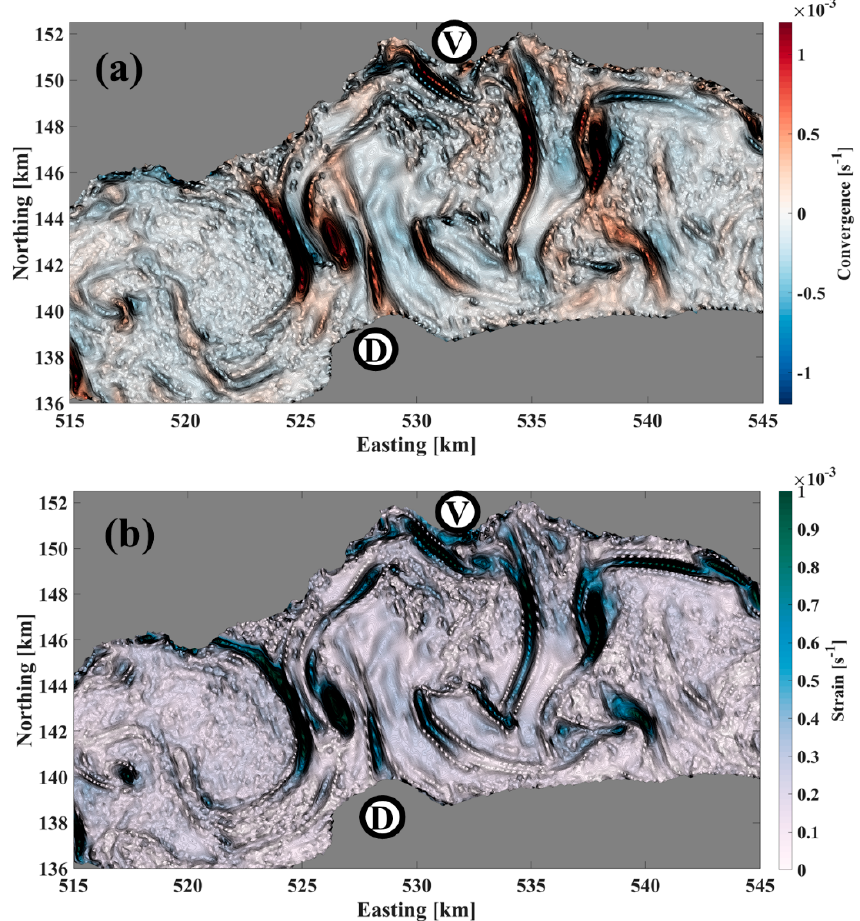
Figure 13. ( a ) Simulated surface convergence, given by ∂ u / ∂ x + ∂ v / ∂ y , and ( b ) horizontal strain rate for 26 October 2021 at 06:00 UTC. V and D are reference points marked in Figure 1.